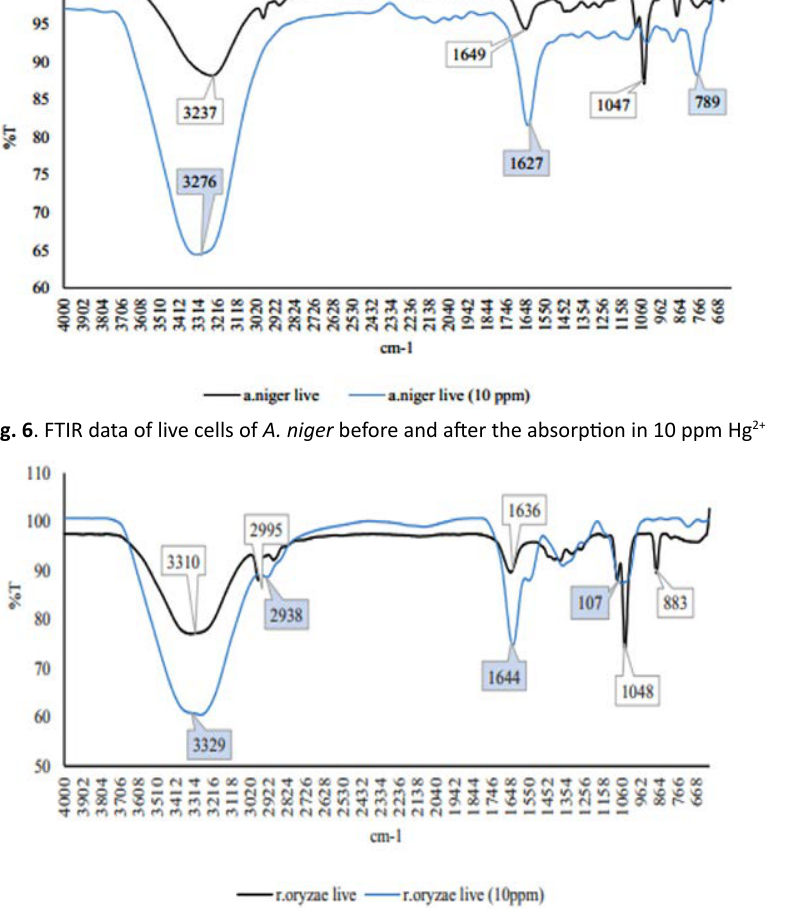
Fig. 7 . FTIR data of live cells of R.oryzae before and after the absorption in 10 ppm Hg